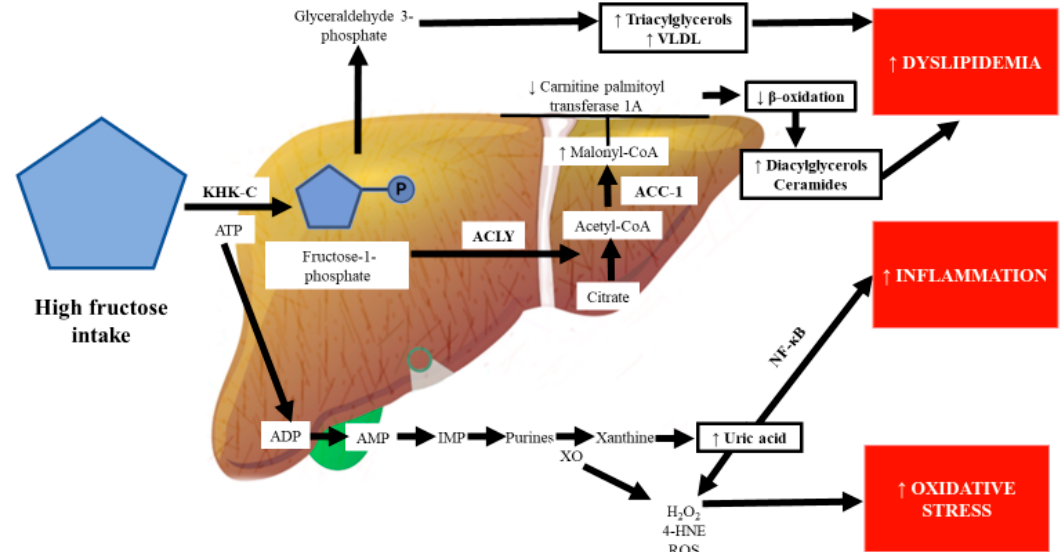
Figure 3. Metabolism of fructose in the liver. Fructose enters hepatocytes and is phosphorylated to fructose 1-phosphate by ketohexokinase C (KHK-C). Fructose 1-phosphate is converted to glyceraldehyde-3 phosphate and is a substrate for the synthesis of triacylglycerols and very-low-density lipoproteins (VLDL). Fructose intake can upregulate the ATP citrate lyase (ACLY) enzyme, promoting citrate breakdown to acetyl-CoA. Acetyl-CoA is converted to malonyl-coenzyme A (malonyl- CoA) by acetyl-CoA carboxylase (ACC-1). Elevated levels of malonyl-CoA inhibit β -oxidation through limiting carnitine palmitoyl transferase 1A, which promotes the accumulation of diacylglycerols and ceramides, causing hepatic dyslipidemia. Moreover, increased KHK-C activity exhausts adenosine triphosphate (ATP), generating adenosine diphosphate (ADP), which is converted to adenosine monophosphate (AMP). In turn, AMP is transformed to inosine monophosphate (IMP), increasing purine production. Xanthine oxidoreductase (XO) produces oxygen reactive species (ROS), hydrogen peroxide (H2O2), 4-hydroxynonenal (4-HNE), and xanthine. Then, xanthine is metabolized, resulting in the overproduction of uric acid and ROS, which induce oxidative stress. Uric acid activates nuclear factor- κ B (NF- κ B), triggering